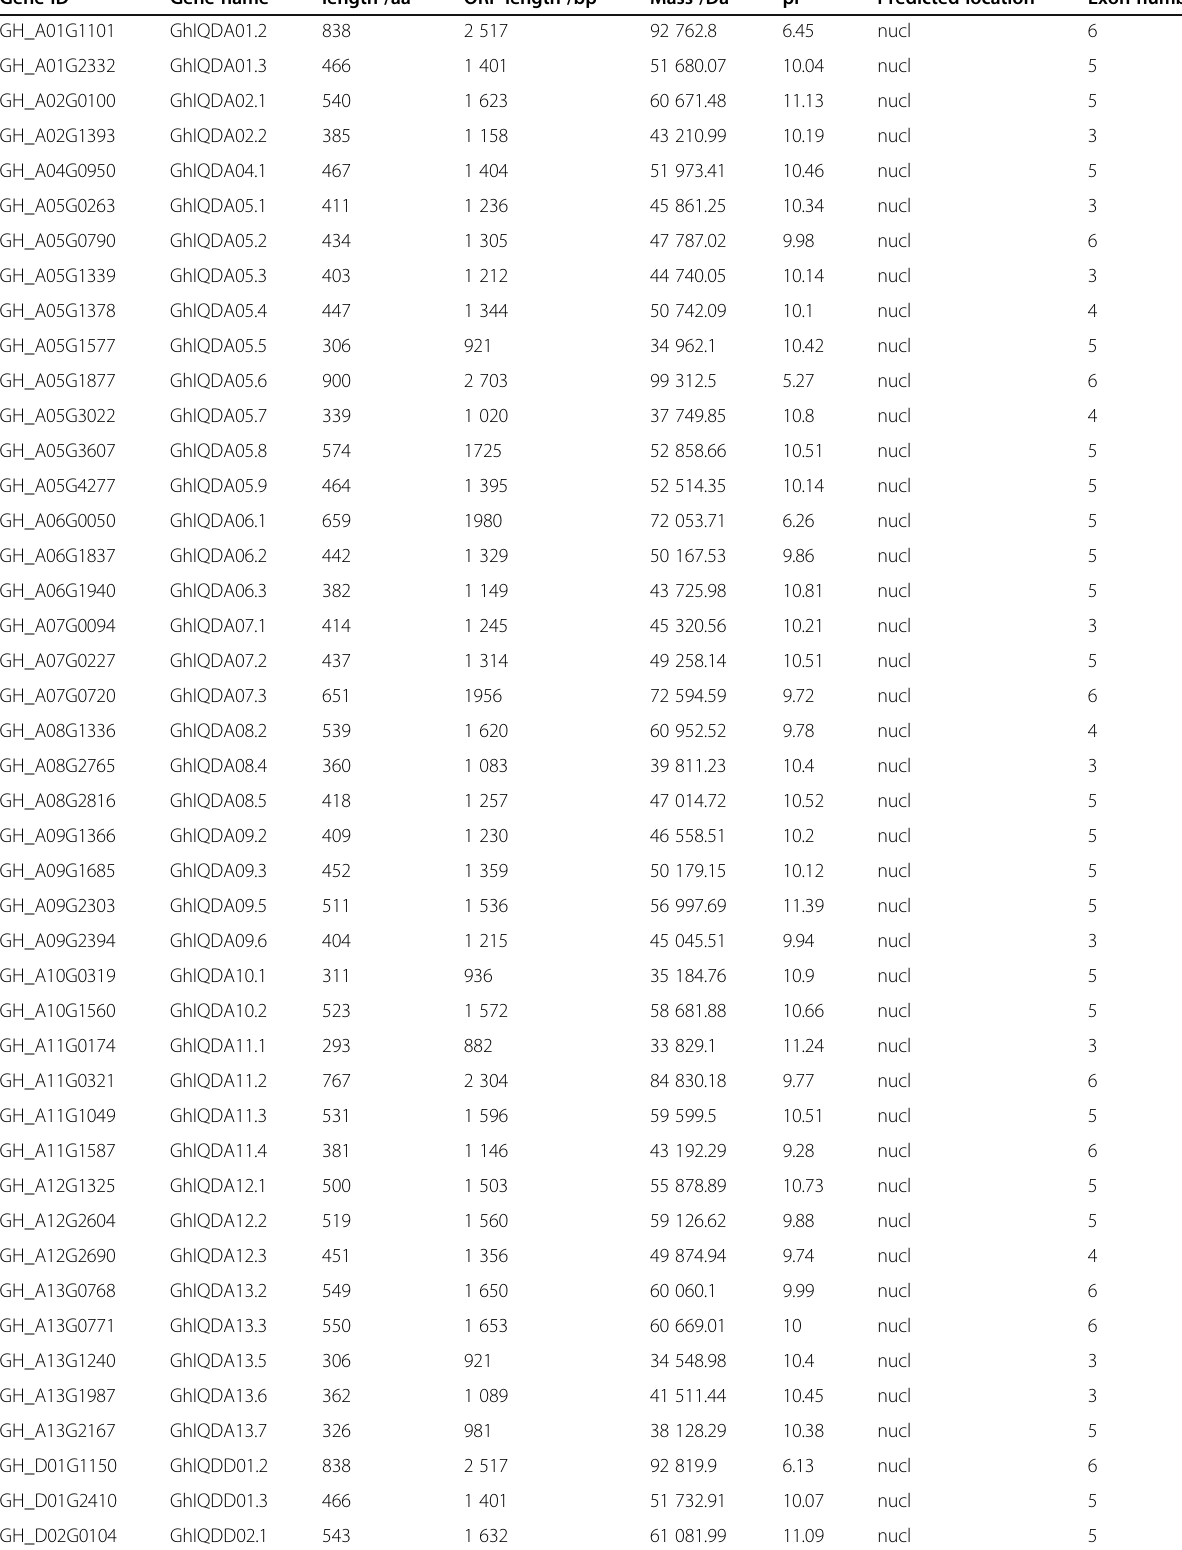
Table 1 Information of GhIQD gene family members in G.hirsutum L., their sequence characteristics and subcellular location Gene